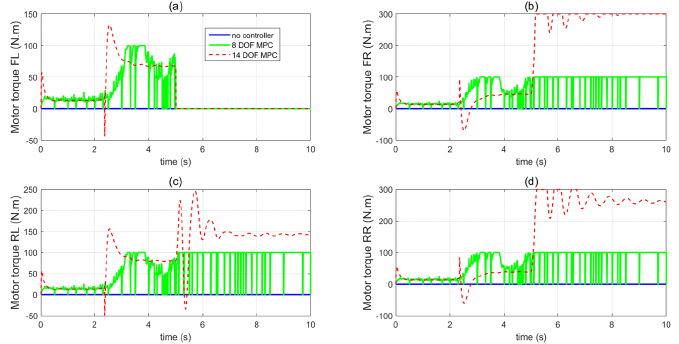
Figure 15. Vehicle dynamics performance when proposed controller applied in the second set of simulations ( a ) longitudinal velocity, ( b ) yaw rate, ( c ) body side-slip angle, ( d ) LTR, ( e ) roll angle, ( f ) scaling factors of 14 DOF MPC.